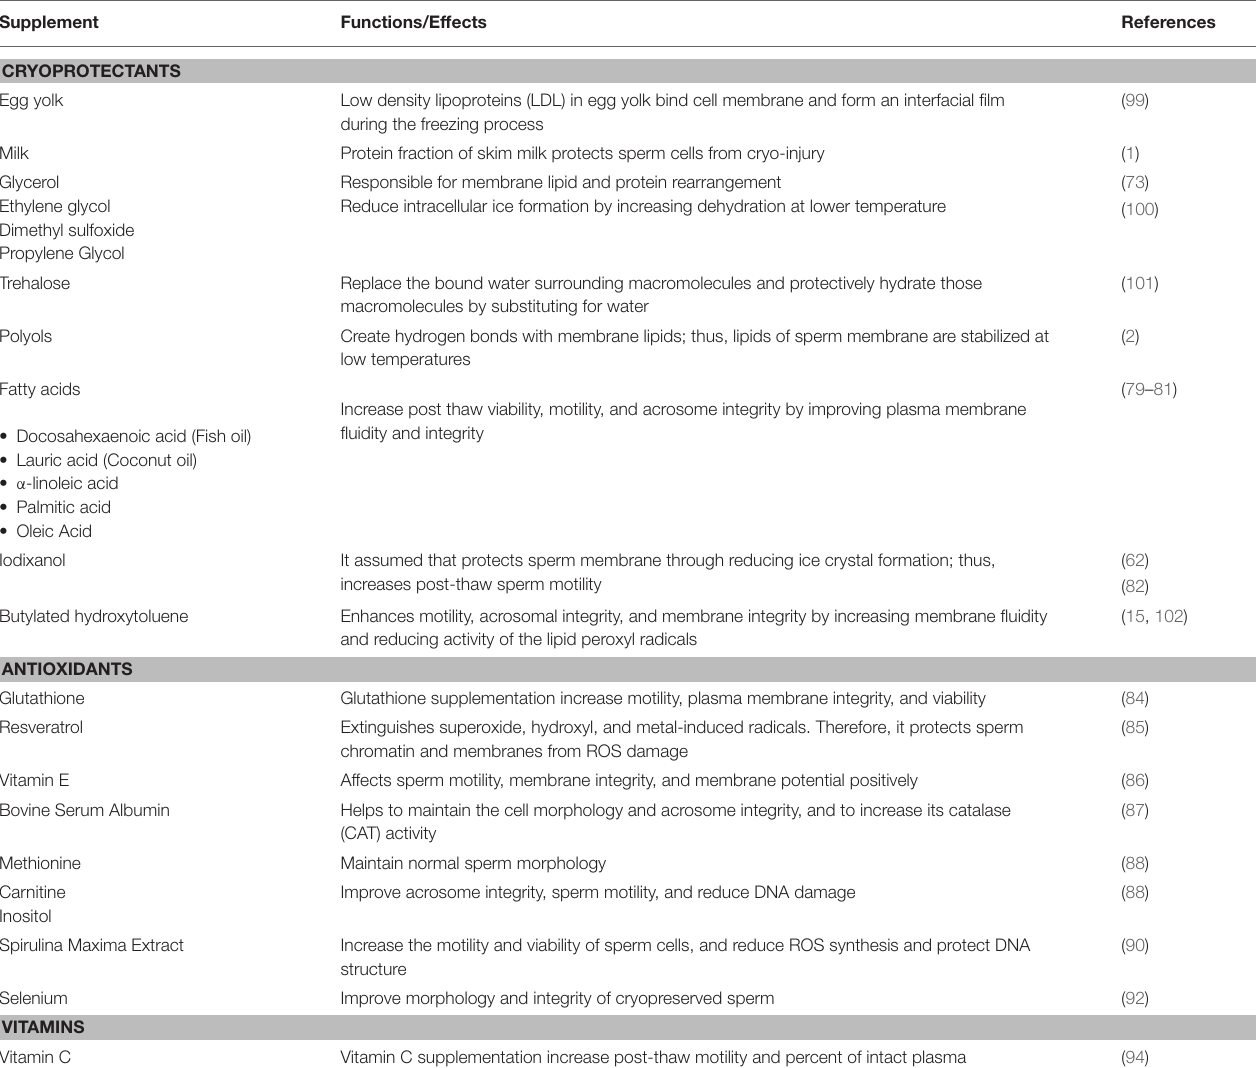
TABLE 1 | Extender development for sperm